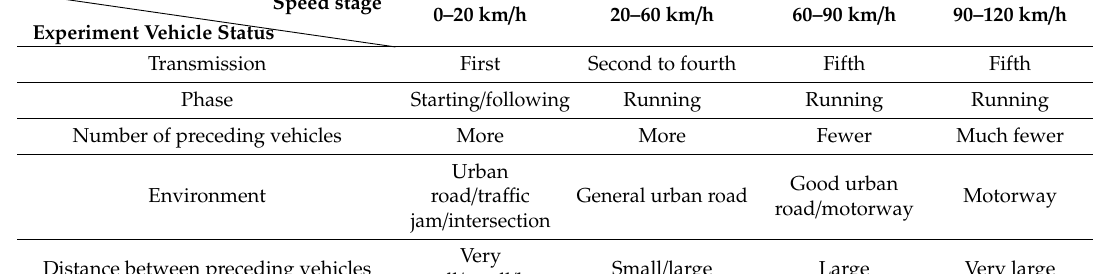
Table 1. Parameters of real vehicle experiment.